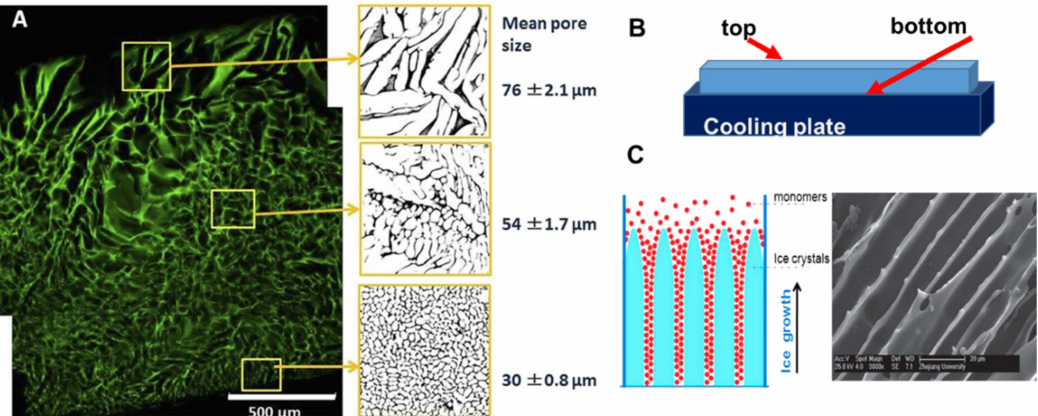
Figure 2. Anisotropic structure in cryogels: ( A ) gelatin cryogel frozen in a petri dish, ( B ) scheme of set up for unidirectional freezing, and ( C ) the scheme of ice-crystals grows and scanning electron microscopy image of PEG-based cryogel. (Figure ( A ) is adapted from [6] and used under a Creative Commons Attribution 4.0 International License and ( C ) is adapted from [59] with permission from The Royal Society of